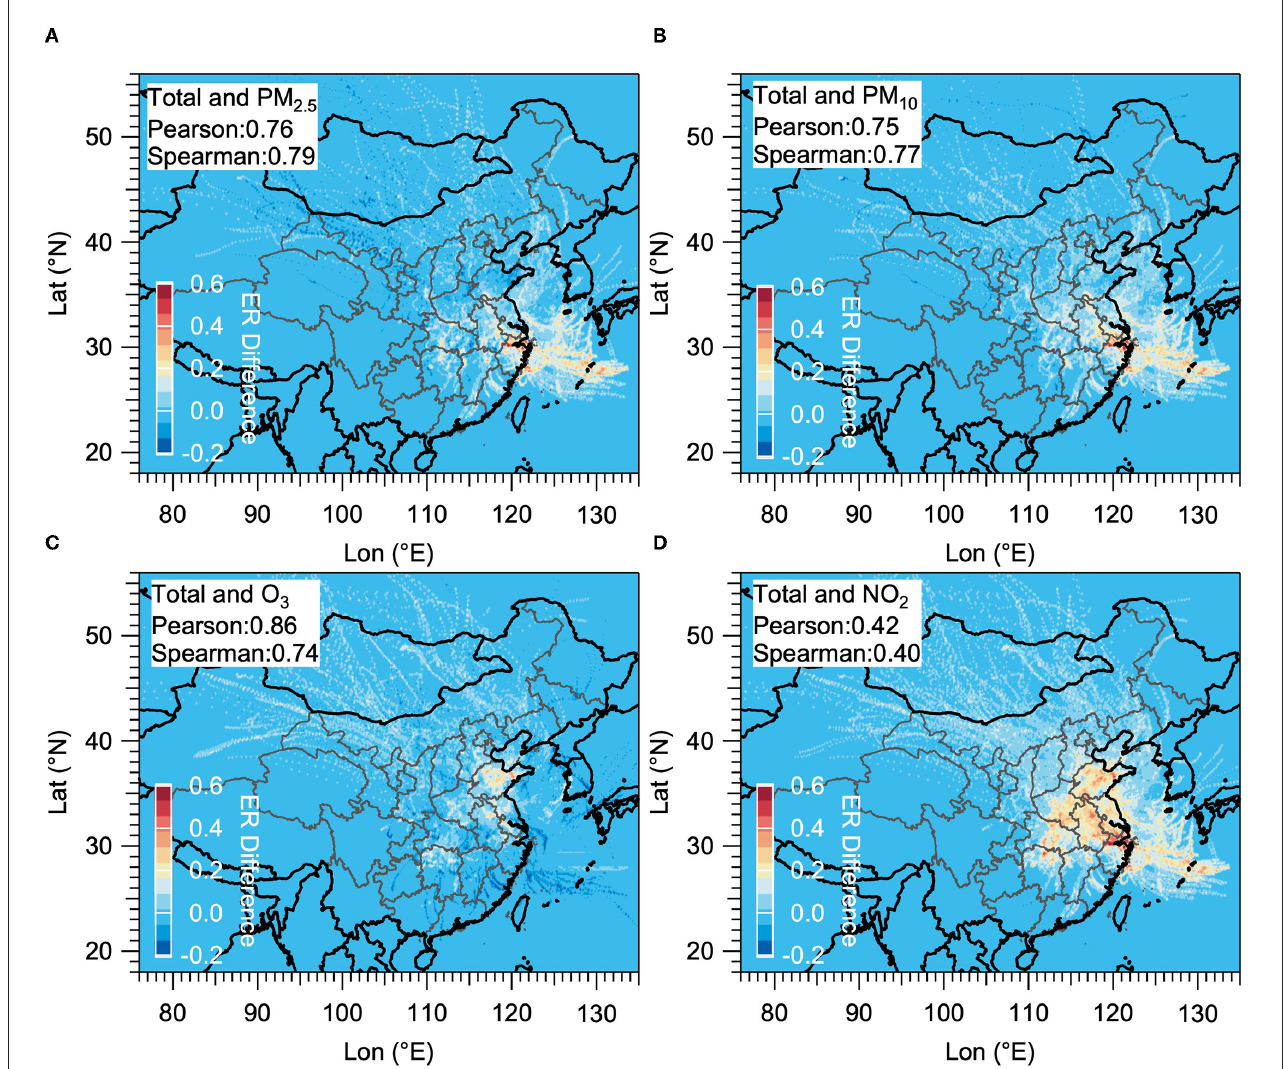
FIGURE7 Distribution of the difference between total ER and ER from individual pollutant, and the Pearson coefficient and Spearman coefficient between the two in Jining. The color scale represents the difference between the total ER and ER from each air pollutant, the areas of hot spots covered can be considered as the PSA for each air pollutant ( A : PM 2.5 ; B : PM 10 ; C : O 3 ; and D : NO 2